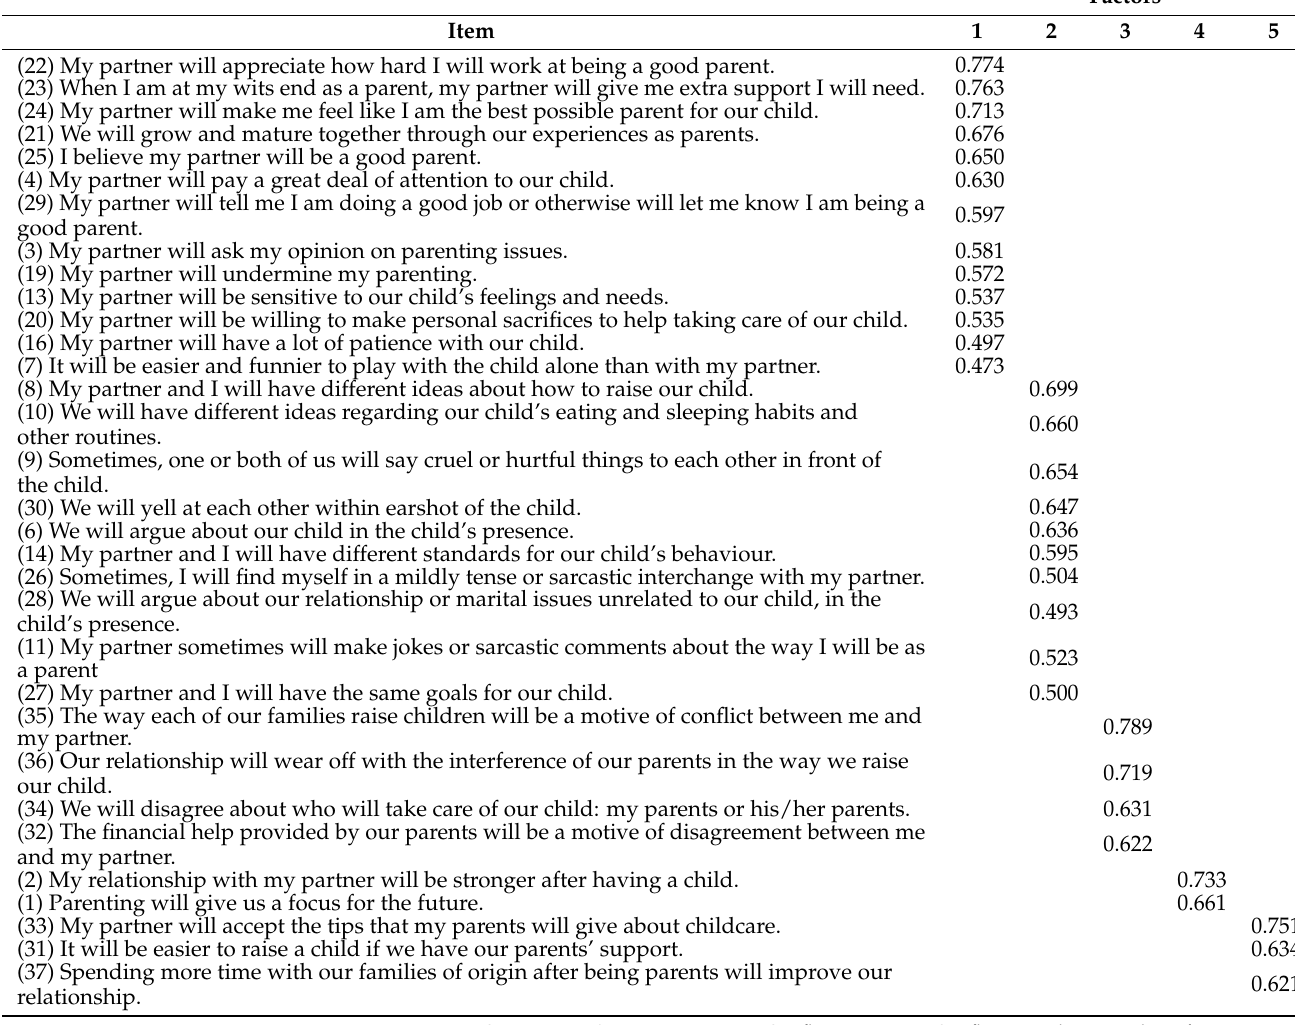
Table 2. Final Exploratory Factor Analysis (EFA) of Prospective Coparenting Relationship Scale (PCRS) with Varimax Rotation and Kaiser Normalization among Heterosexual Sample.